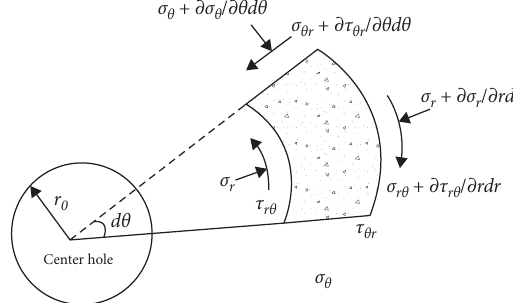
Figure 4: Stress analysis of one rock element in the plastic zone.